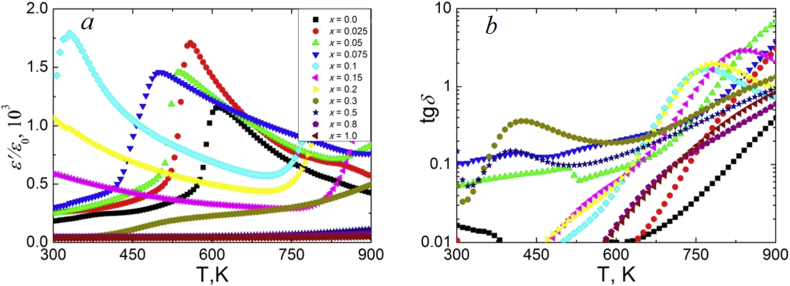
Temperature dependences of ε'/ε0 (a) and tgδ (b) at 100 kHz for NCN solid solutions.